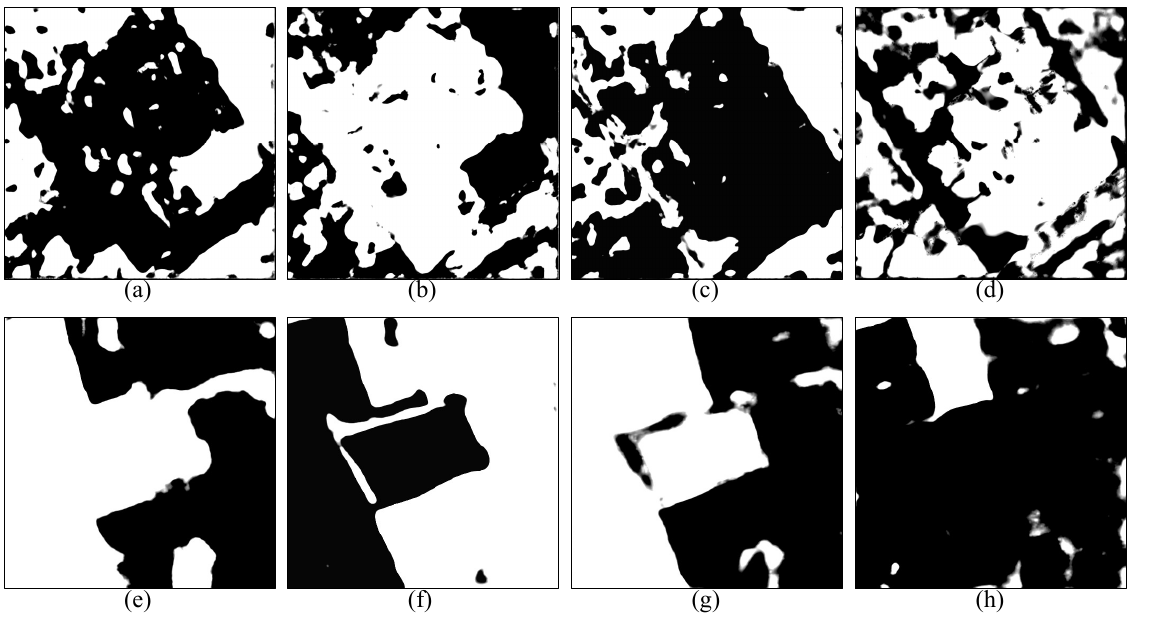
Figure 17. Visualization of deep features extracted by the multitask feature extractor without pa- rameter fine-tuning. ( a – d ) Deep features of X-band SAR images. ( e – h ) Deep features of C-band SAR images.